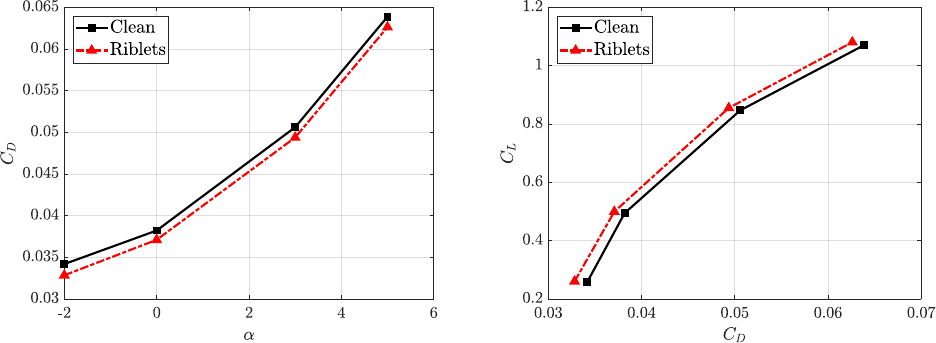
Figure 10. C D ( α ) and polar curves of the UAV, in clean/riblets